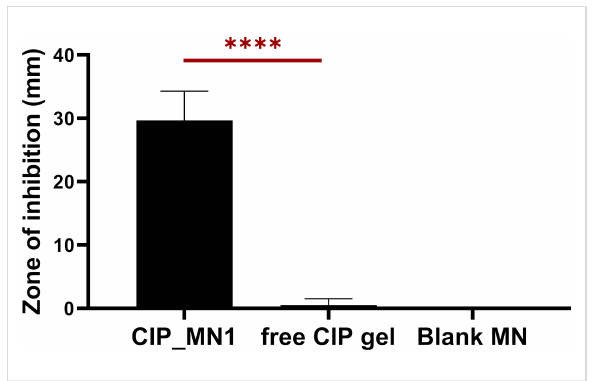
Figure 8: Antibacterial activity of CIP_MN1 applied on an in vitro skin model mounted on S. aureus -inoculated agar. **** p < 0.0001; n = 3.